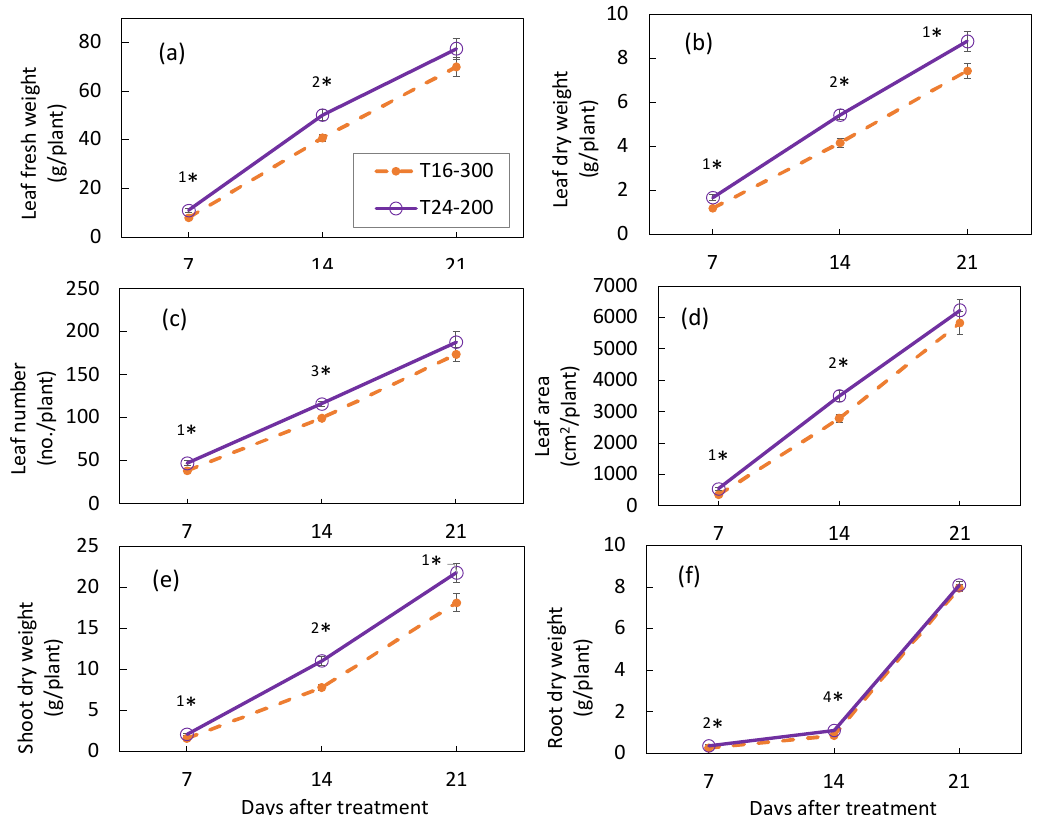
Figure 2. Leaf fresh ( a ) and dry weight ( b ), leaf numbers ( c ), leaf area ( d ), shoot dry weight ( e ), and root dry weight ( f ) of nasturtium grown under T16-300 and T24-200 at 7, 14, and 21 days after treatment. Values are the means ± SE ( n = 6). Asterisks indicate significant differences between the treatments ( 1 *, p < 0.05; 2 *, p < 0.01; 3 *, p < 0.001, and 4 *, p < 0.0001), determined by the t -test. Plant density during the 1st, 2nd, and 3rd weeks was 21.5, 16.7, and 11.1 plants m −2 , respectively.